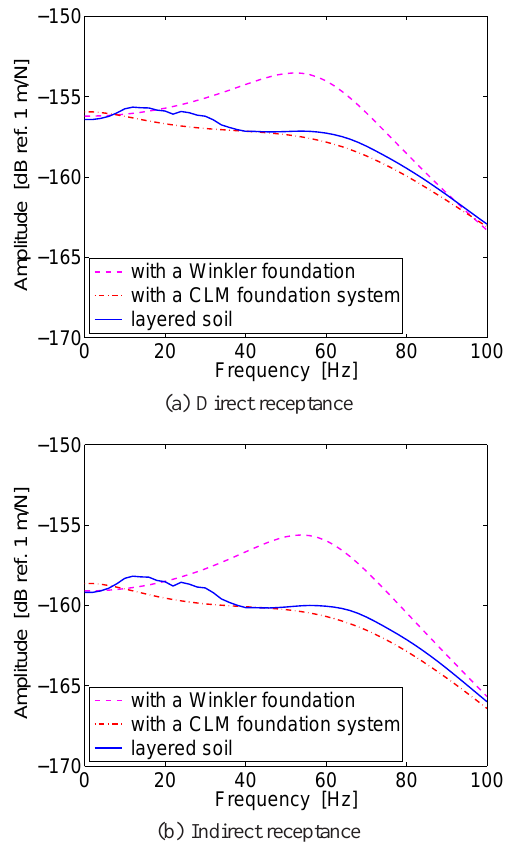
Figure 9. Track receptances of the studied site (M´evernies – Bel- gium)